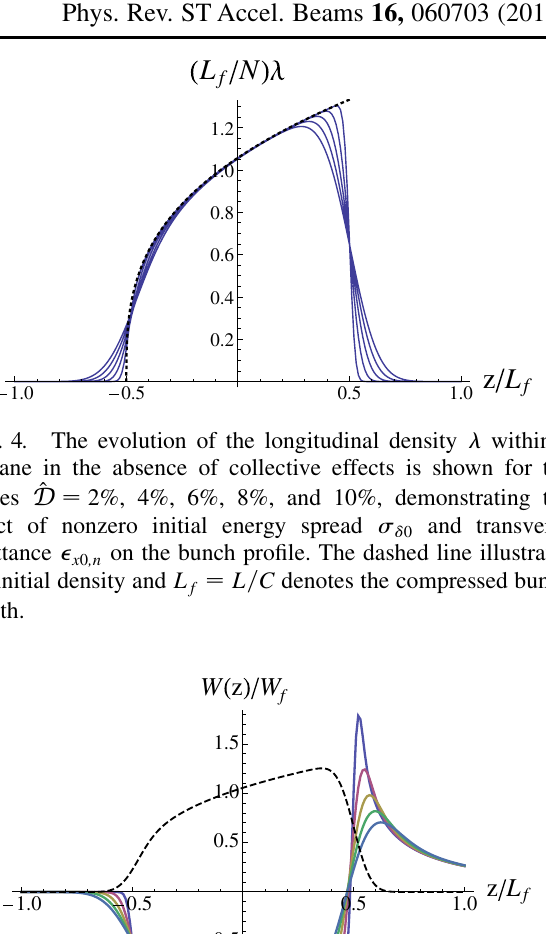
^ D ¼ 2% , 4%, 6%, on the longitudinal x 0 ;n =N Þ (cid:1) for the f ¼ 1 = 2 will experience a f